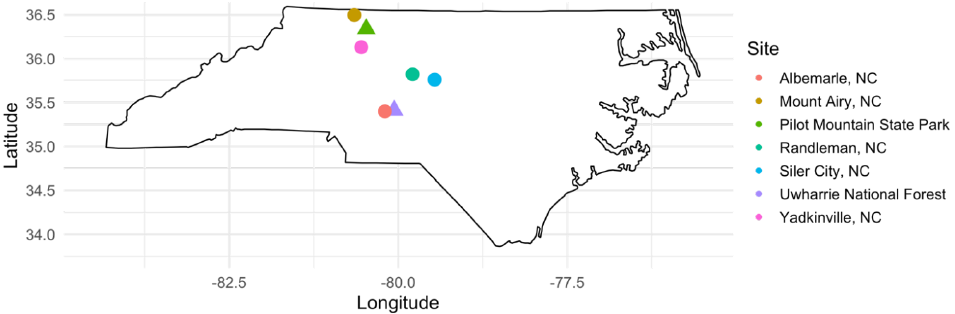
Figure 2. Location of the field collection sites (triangles), Uwharrie National Forest (purple triangle) and Pilot Mountain State Park (green triangle), and weather station sites (circles) in North Carolina (NC),